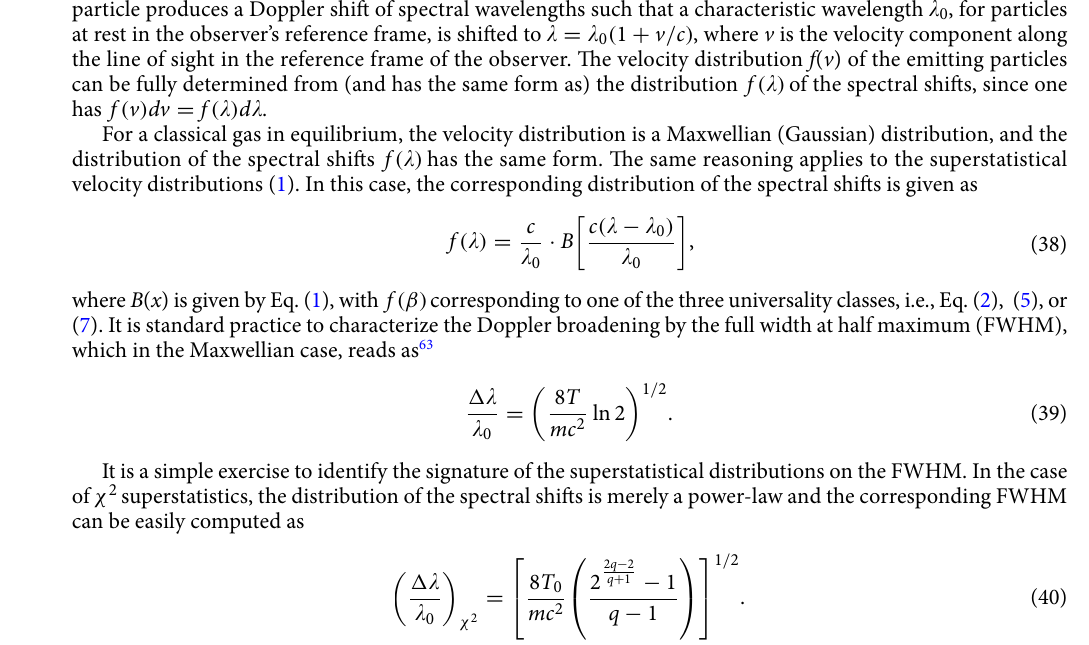
Figure 5. Normalized Landau time for the three universality classes of superstatistics: χ ( b , e ), and log-normal ( c , f ) superstatistics. The top panel corresponds to Langmuir modes, i.e. Eqs. (29)–(31), whereas the bottom panel corresponds to IAWs, i.e., Eqs.